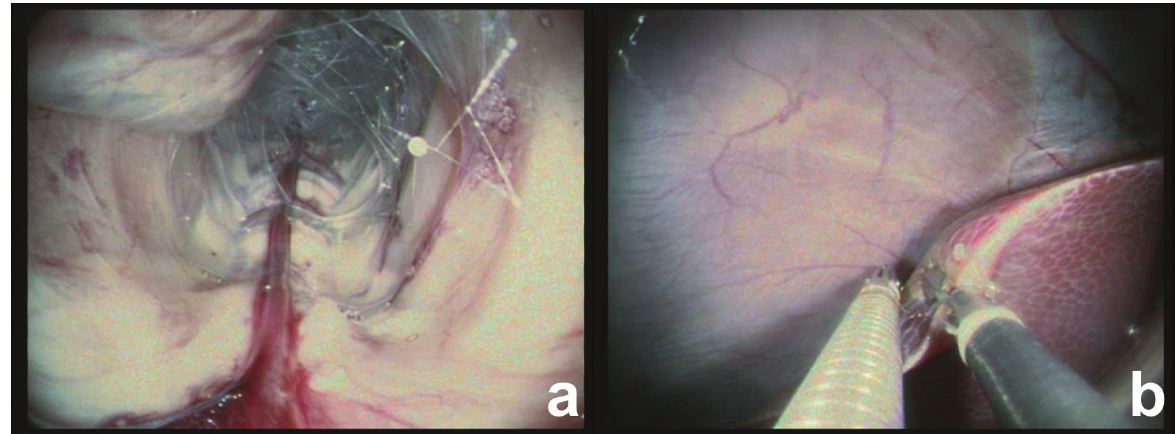
Figure 1 - Transcolonic images of swine models, obtained with a fl exible endoscopic. a. NOTES retroperitoneoscopy visualization in swine models. b. Visualization of liver biopsies during transcolonic NOTES in swine models.